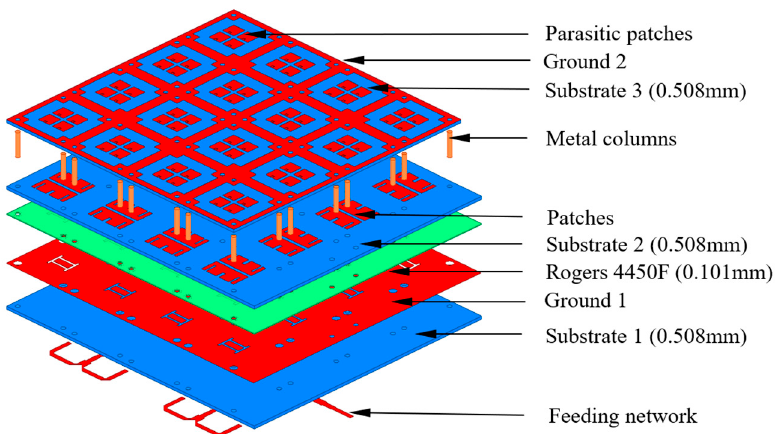
Figure 10. Structure of the proposed 4 × 4 antenna array.